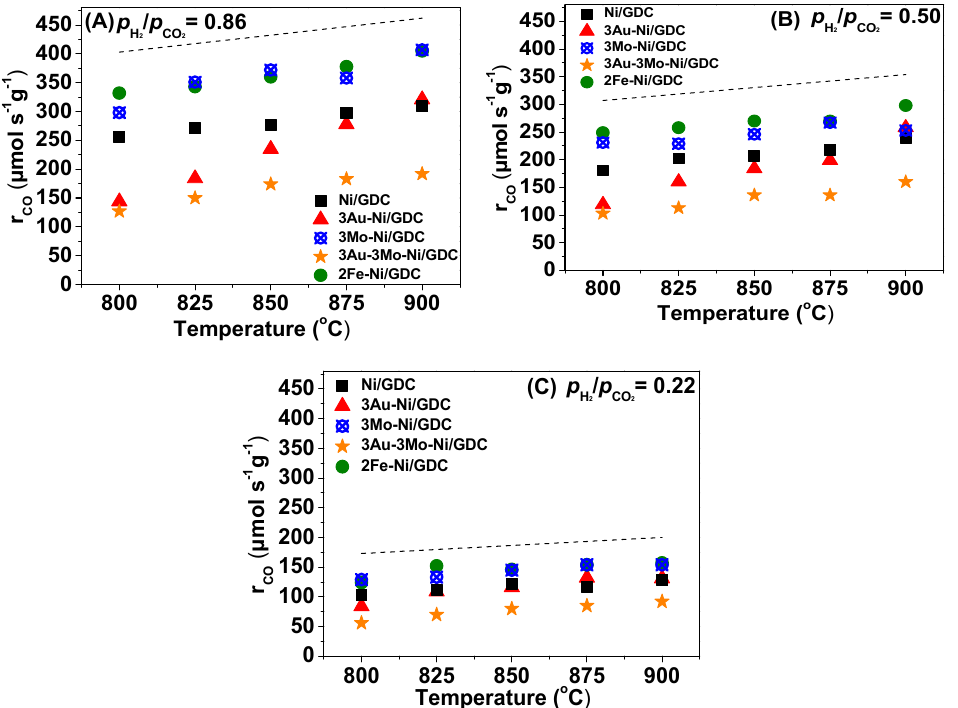
Figure 4. CO production rates ( μ mol s − 1 g − 1 ) on ESCs comprising: Ni/GDC, 3Au- Ν i/GDC, 3 Μο - Ν i/GDC, 3Au – 3 Μο - Ν i/GDC, and 2Fe-Ni/GDC, as fuel electrodes, in the range of 800 – 900 °C under three different mixtures: ( A ) 24.5% H 2 O − 24.5% CO 2 − 21% H 2 (P H2 /P CO2 = 0.86), ( B ) 28% H 2 O − 28% CO 2 − 14% H 2 (P H2 /P CO = 0.50), and ( C ) 31.5% H 2 O − 31.5% CO 2 − 7% H 2 (P H2 /P CO 2 = 0.22). Dilution of He: 30 vol.% and F total = 140 cm 3 /min (STP conditions: 0 ◦ C, 1 atm) in all cases. The dash line (– –) corresponds to the r CO values in thermodynamic equilibrium. All studied electrodes have similar loading in the range of 10–12 mg/cm 2